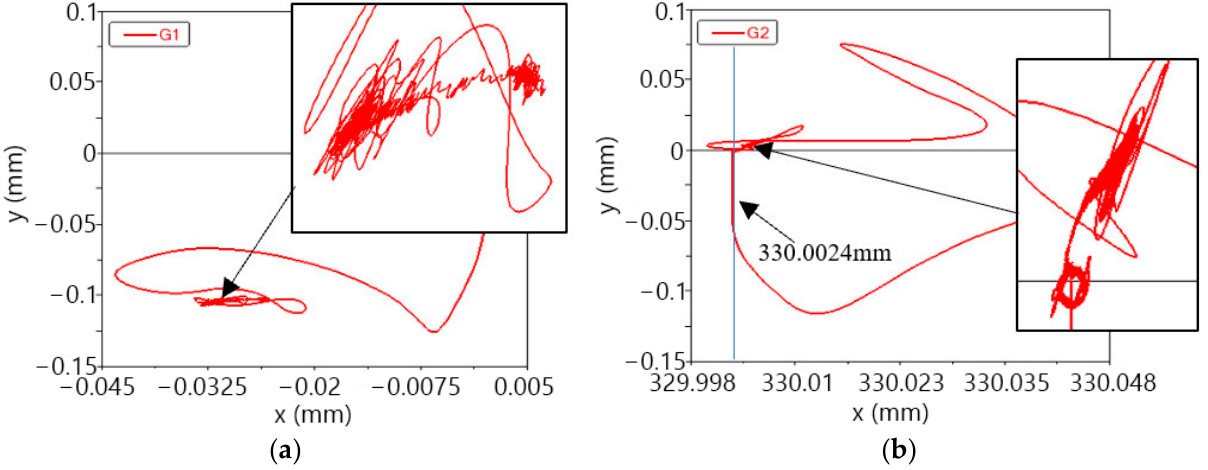
Figure 3. Dynamic response of ordinary rotating machinery: position curve of ( a ) driving gear center and ( b ) driven gear center.